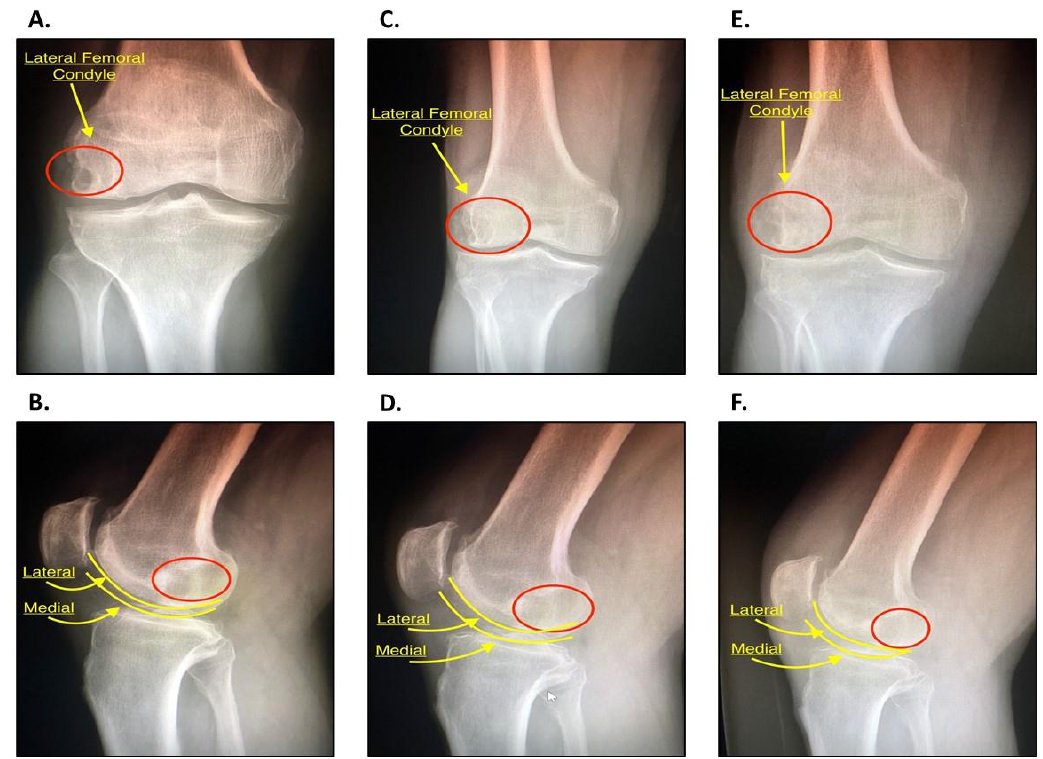
Figure 6. ( A ) Anteroposterior (AP) radiograph of the right knee, pre-operative. The lateral femoral condyle can be visualized with the area of decreased opacity representing the SC (red circle). The joint space is well preserved with mild patellofemoral OA with osteophytes. ( B ) Lateral radiograph of the right knee, pre-operative. The red circle depicts the same SC. The lateral and medial femoral condyles are outlined in yellow. Both 6A and 6B will be used as a baseline for comparison. ( C ) AP radiograph of the right knee 3 months following IOBP. The lateral femoral condyle can be visualized with signs that the area of the previous SC is filling (red circle). ( D ) Lateral radiograph of right knee 3 months following operation. The red circle depicts the area of the SC. ( E ) AP radiograph of the right knee 6 months following IOBP. The area of the previous SC (red circle) has increased in opacity in comparison to the previous image at 3 months. ( F ) Lateral radiograph of the right knee six months following IOBP. The area of the previous SC (red circle) is more opaque, an indication that there is progressing filling of the previous lesion. This suggest that the IOBP has been successful.